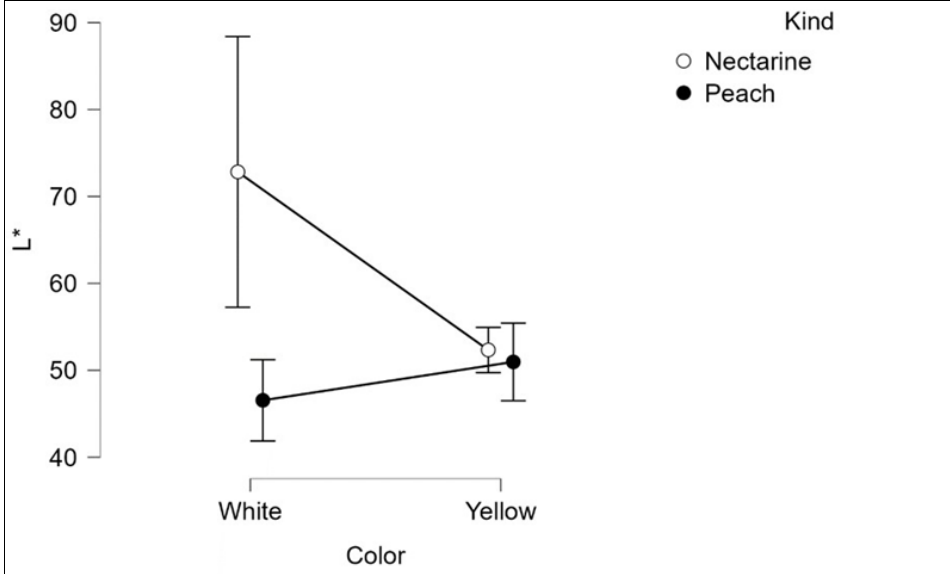
Figure 2. Scatter plots showing statistical interaction between color and type in peach and nectarine cultivars.